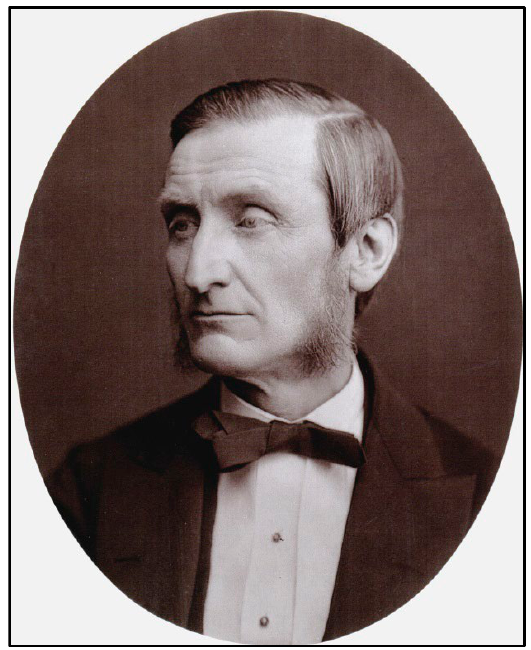
Figure 2. J. H. Gladstone (1827-1902). Source: https://en.wikipedia. org/wiki/John_Hall_Gladstone.